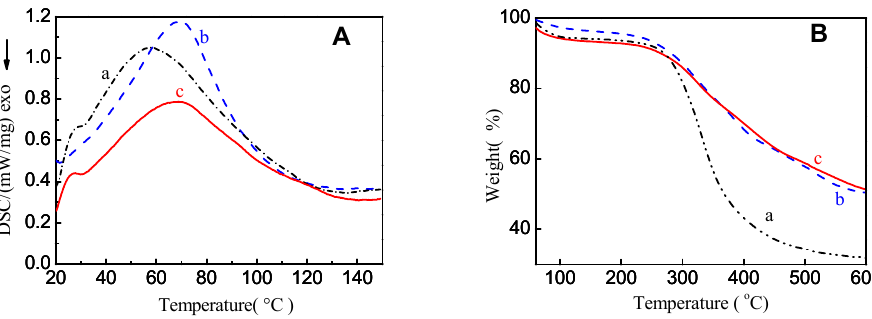
Figure 3. DSC ( A ) and TG ( B ) profiles. ( a ) Collagen Fiber, ( b ) MNp-Col support, and ( c ) MNp-Col-IL.